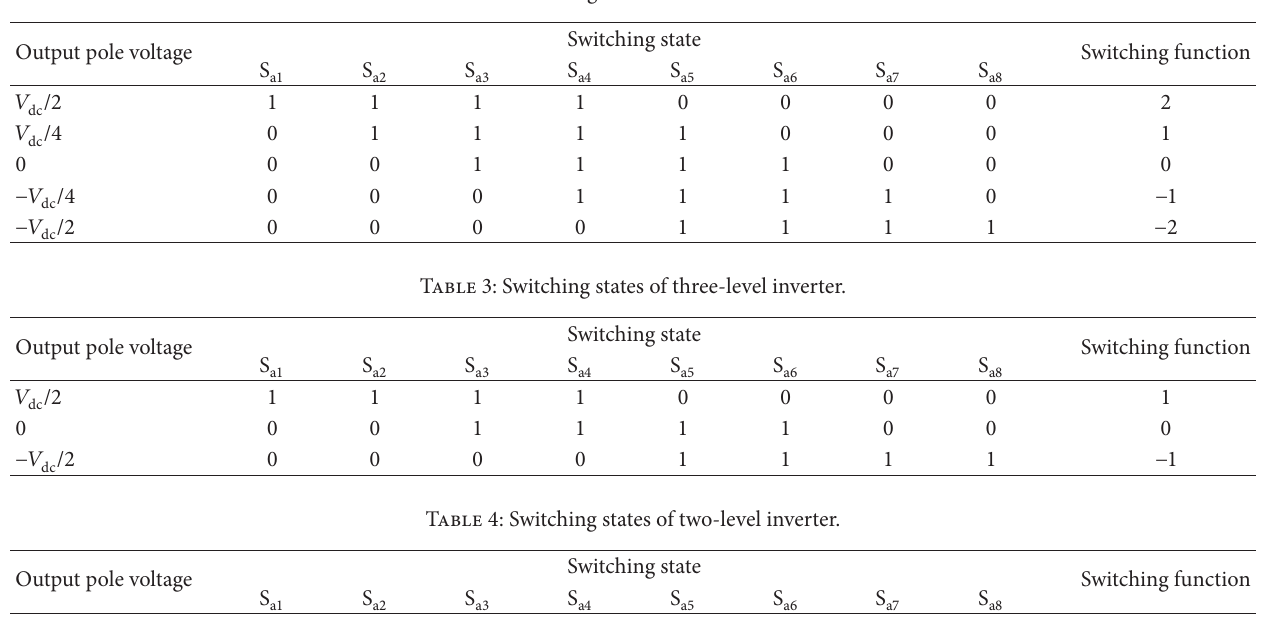
Table 2: Switching states of five-level inverter.